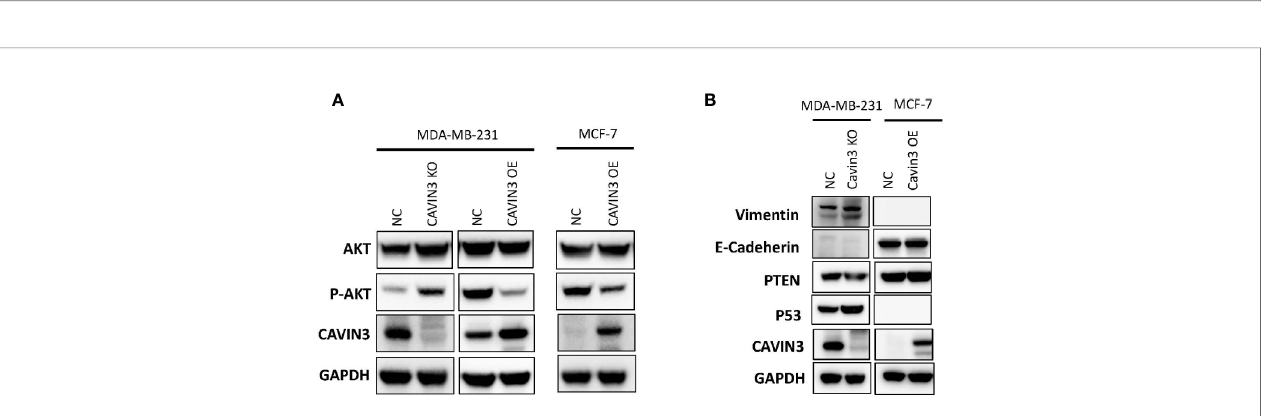
FIGURE 4 | Impact of cavin3 on cell migration. Overexpression of cavin3 inhibits cancer cell migration (A, C) ; (B) Knockout of cavin3 promote breast cancer cell migration. **p<0.01; ***p<0.001. KO, knockout; NC, normal control; OE, overexpression.